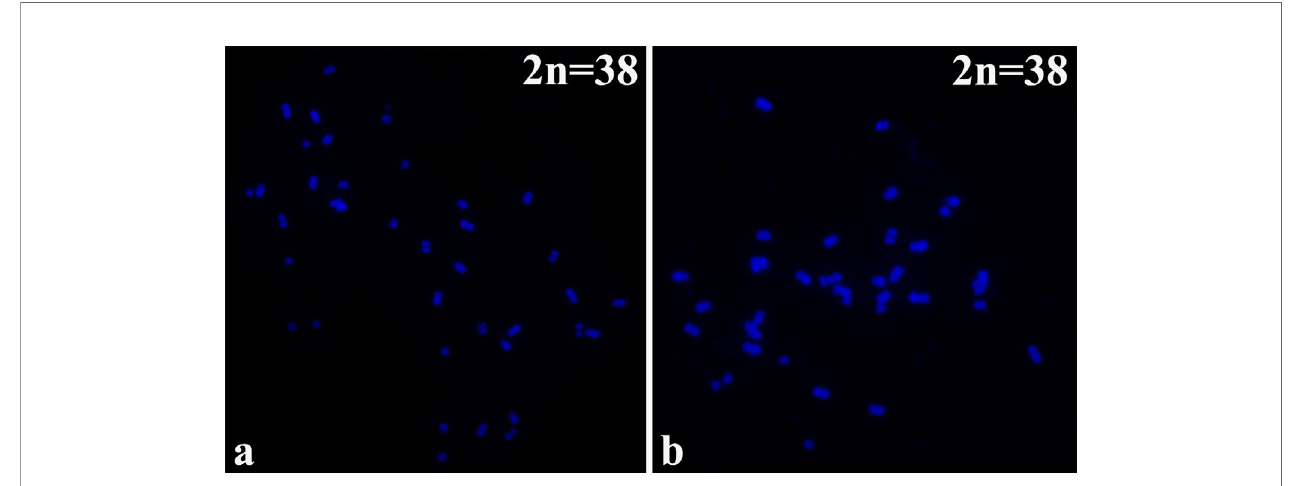
FIGURE 1 | The chromosomes were counter stained with the DAPI solution. B. napus cultivars of (A) 16NTS309 and (B)